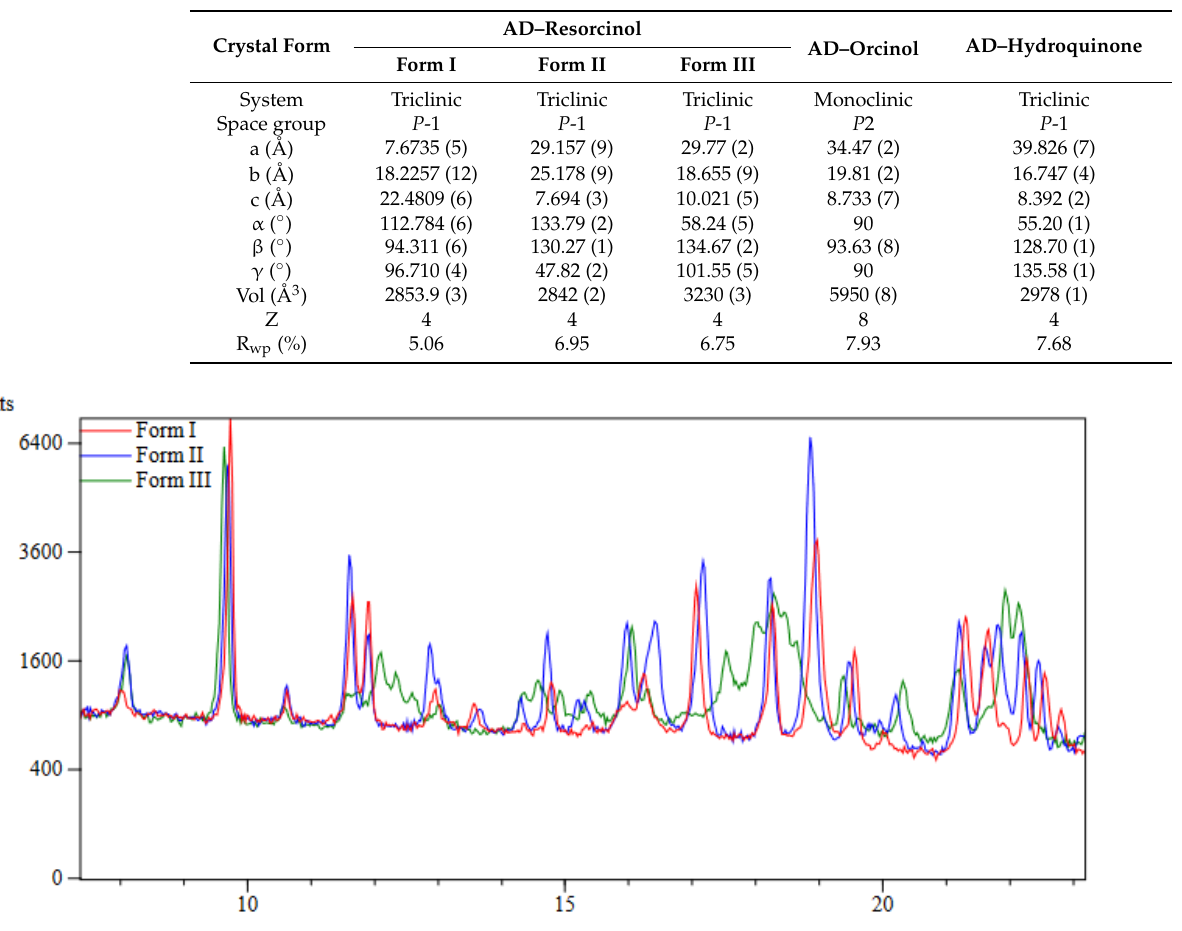
Table 2. Comparative crystallographic data from XRPD of AD cocrystals at 298 K.